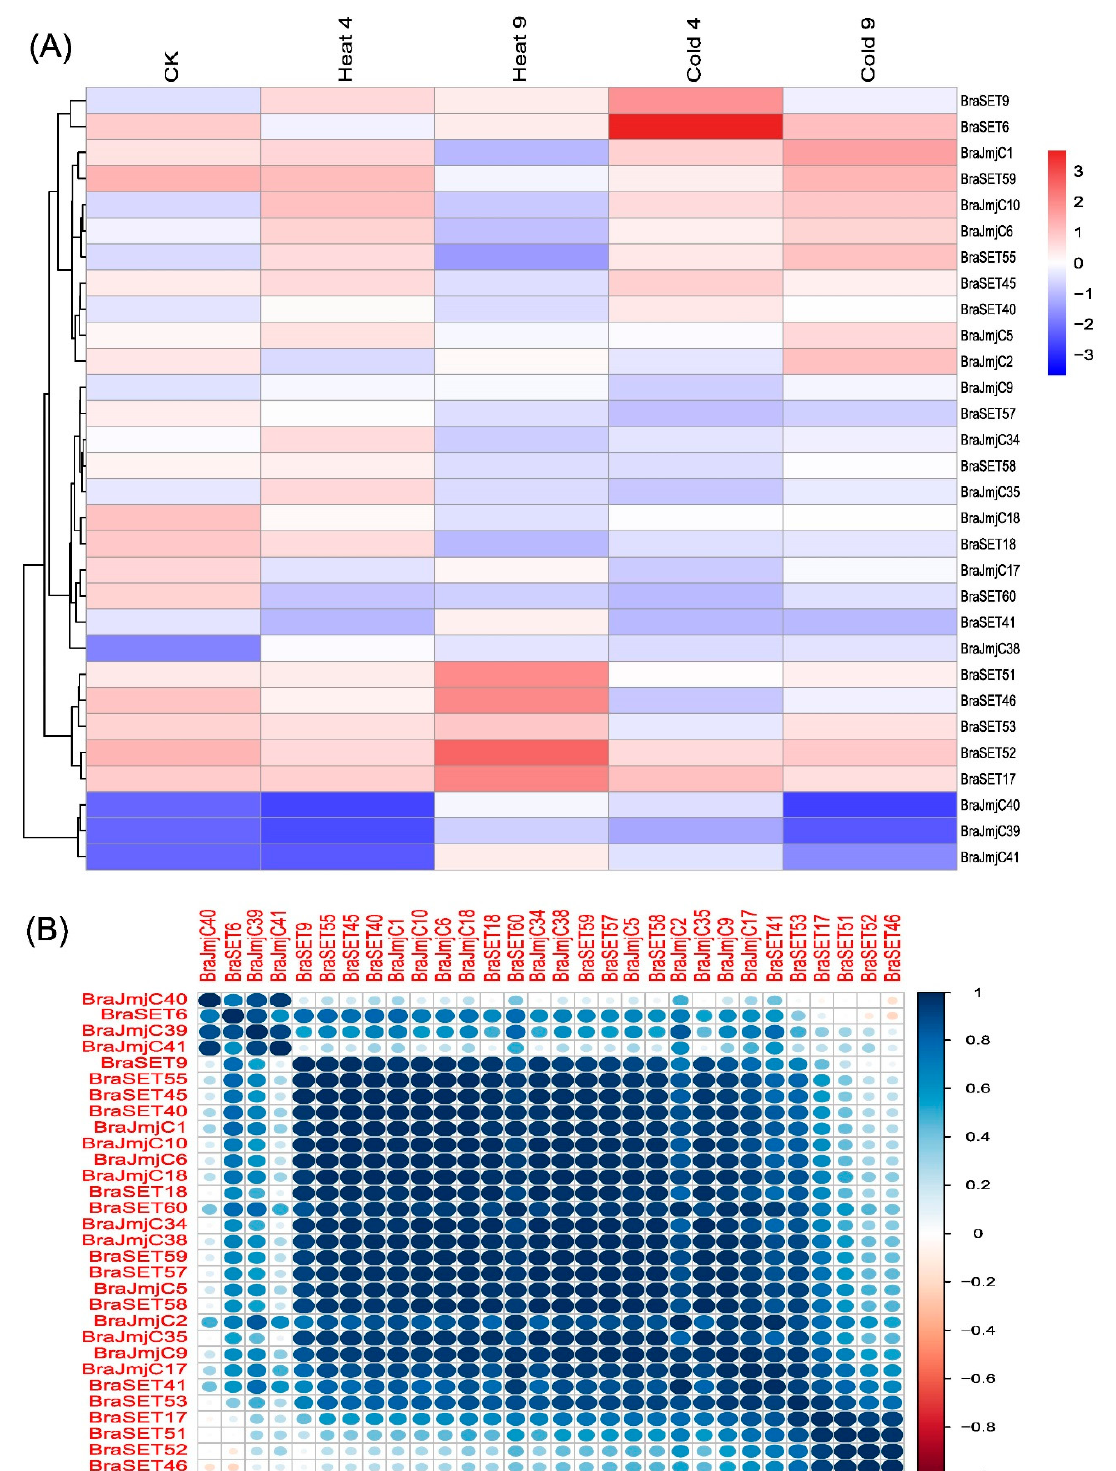
Figure 6. ( A ) Relative expression (log 2 fold-change) analysis of SET and JmjC genes under CK, heat and cold stress treatments in B. rapa . ( B ) Pearson’s correlation coe ffi cients (PCCs) of relative gene expression of 15 paralogous pairs used for RT-PCR analysis during heat and cold stress treatments.